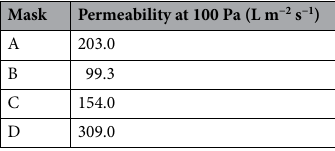
Table 1. Permeability of 4 masks models used in this